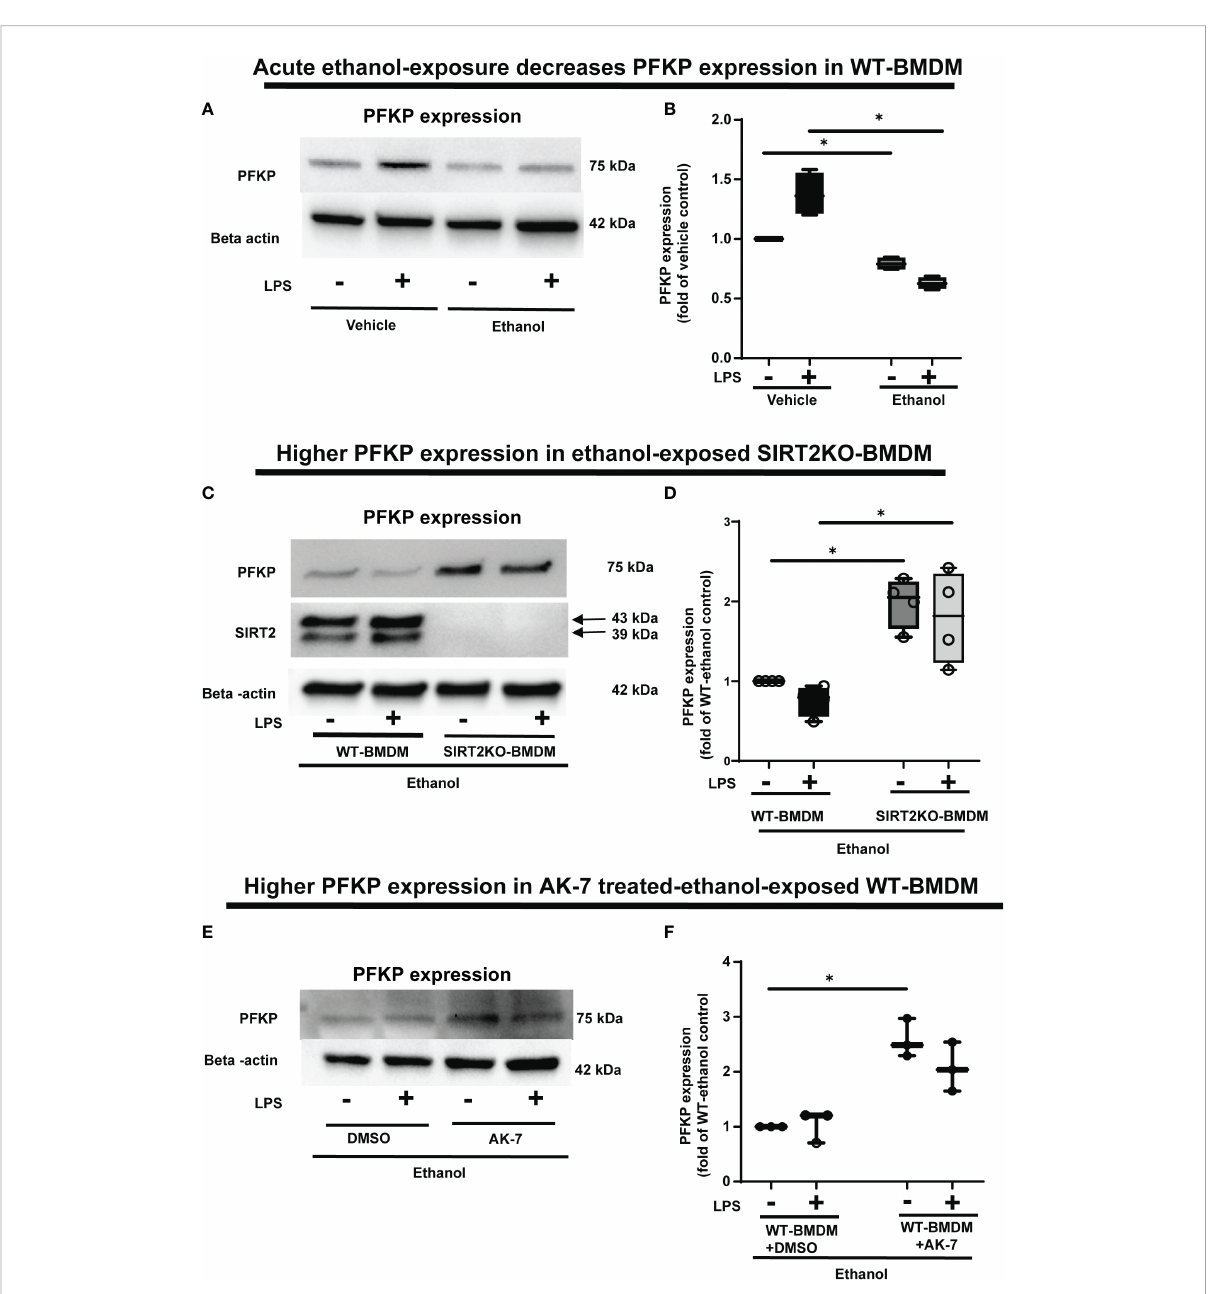
FIGURE 4 The effect of acute ethanol-exposure-induced SIRT2 on PFKP expression in macrophages. (A) PFKP expression in WT-BMDM exposed to vehicle or ethanol ± LPS by western blot analysis. (B) PFKP western blot image quanti fi cation of PFKP protein in vehicle vs. ethanol exposed WT-BMDM, Y axis represents fold of vehicle-LPS (fold of vehicle control) (n = 4 blots; * p < 0.05). (C) PFKP expression in Ethanol-exposed WT-BMDM and SIRT2KO-BMDM ± LPS. (D) Western blot image quanti fi cation of PFKP protein in ethanol exposed WT-BMDM and SIRT2KO-BMDM. Y axis represents fold of Ethanol-exposed WT-LPS (fold of WT- ethanol control) (n = 4 blots; * p < 0.05). (E) PFKP expression in Ethanol-exposed WT- BMDM treated with AK-7 or DMSO ± LPS. (F) Western blot image quanti fi cation of PFKP in AK-7 vs. DMSO treated-Ethanol-exposed WT-BMDM ± LPS, Y axis represents fold of Ethanol-exposed WT-LPS (fold of WT- ethanol control) (n = 4 blots; * p <